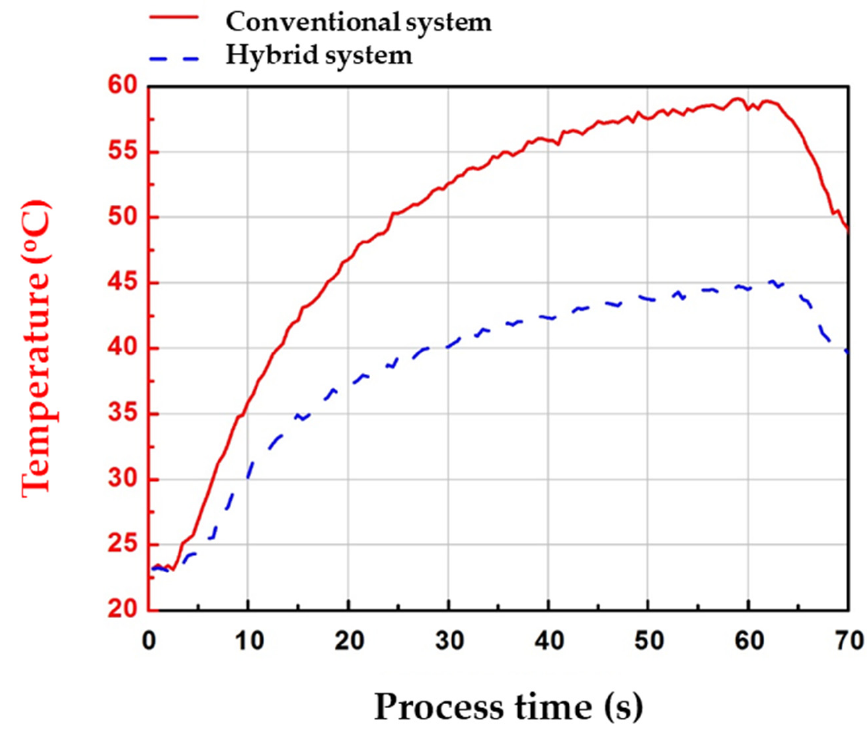
Figure 11. Pad temperature comparison between the conventional and hybrid systems based on the process